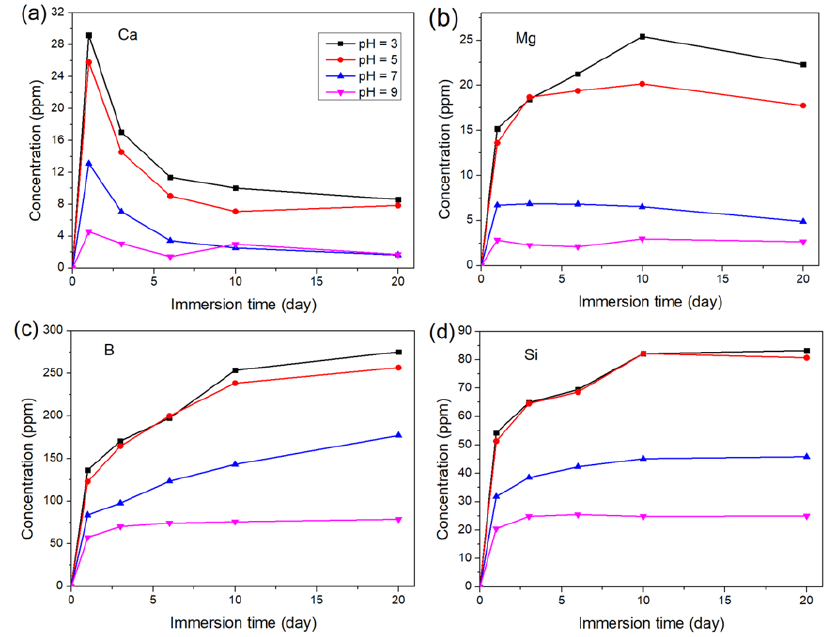
Figure 6. Time-dependent release of ( a ) Ca, ( b ) Mg, ( c ) B, and ( d ) Si of the glass samples in K 2 HPO 4 solutions with different initial solutions with different initial pH.